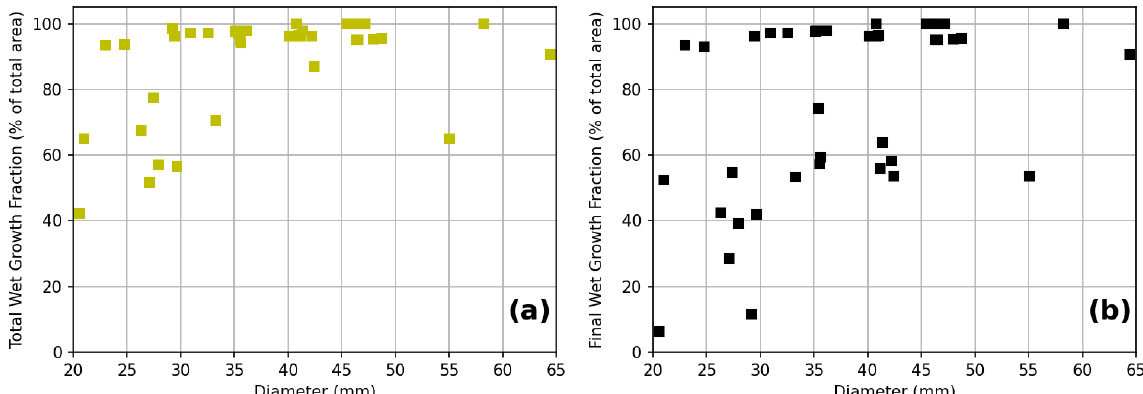
Figure 10. Hailstone properties derived from the umax31 storm of Kumjian and Lombardo (2020) as a function of diameter. These properties include the wet growth across the hailstone cross section as a fraction of the total area and the final wet-growth layer as a fraction of the total